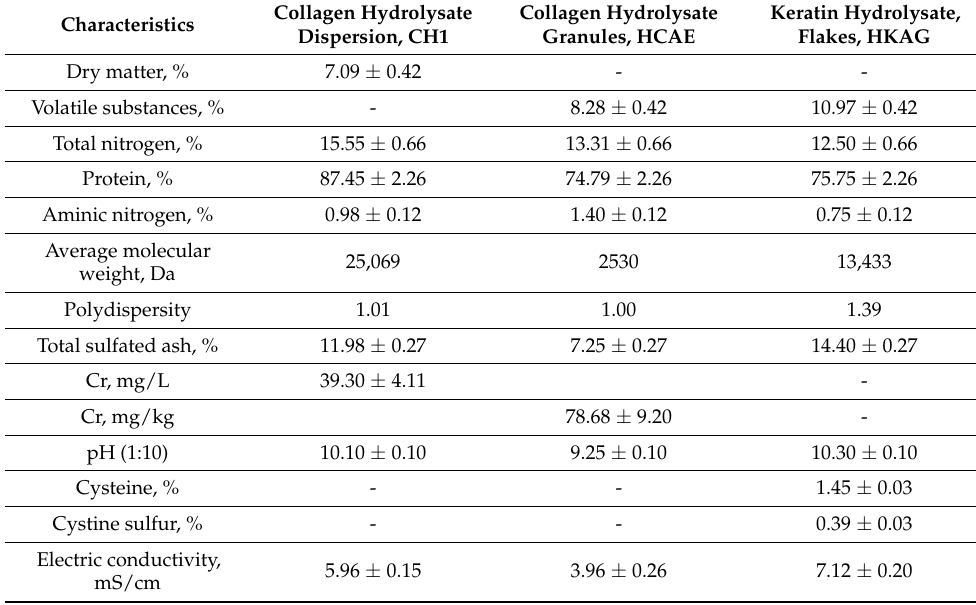
Table 1. Physical–chemical characteristics of protein